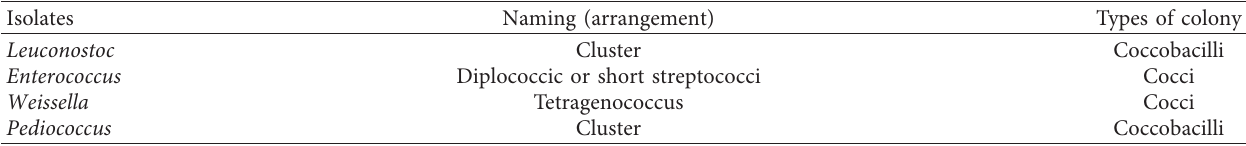
Table 2: Micromorphology of bacteria isolated from Borde and finfish.